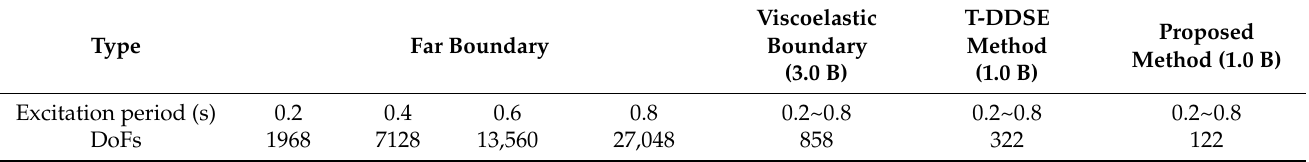
Table 1. Comparison of calculation scale of far-field simulation by different